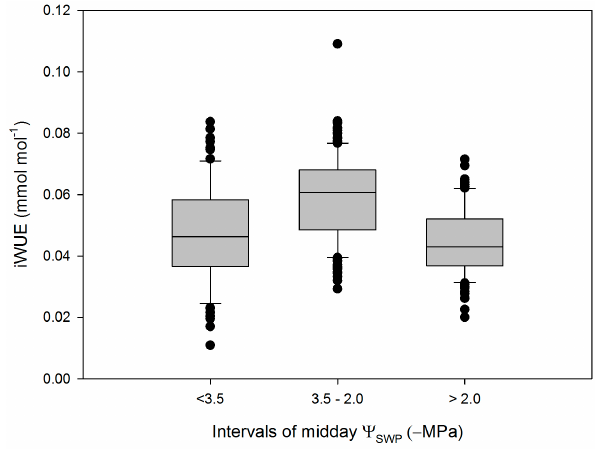
Figure 4. Intrinsic water use efficiency (iWUE, mmol mol − 1 ) for the selected midday stem water potential ( Ψ SWP , MPa) intervals.